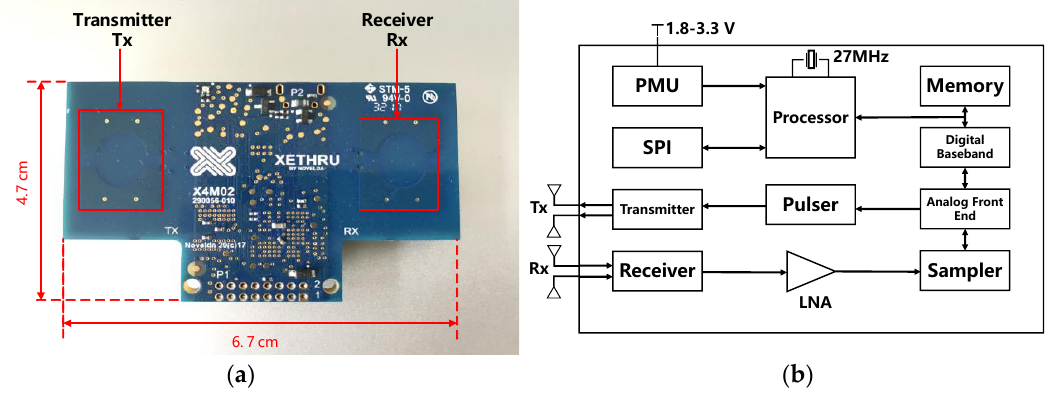
Figure 2. IR − UWB radar equipment and its structure diagram. ( a ) Radar equipment diagram. ( b ) Figure 2. IR-UWB radar equipment and its structure diagram. ( a ) Radar equipment diagram. Radar equipment structure diagram. ( b ) Radar equipment structure diagram.